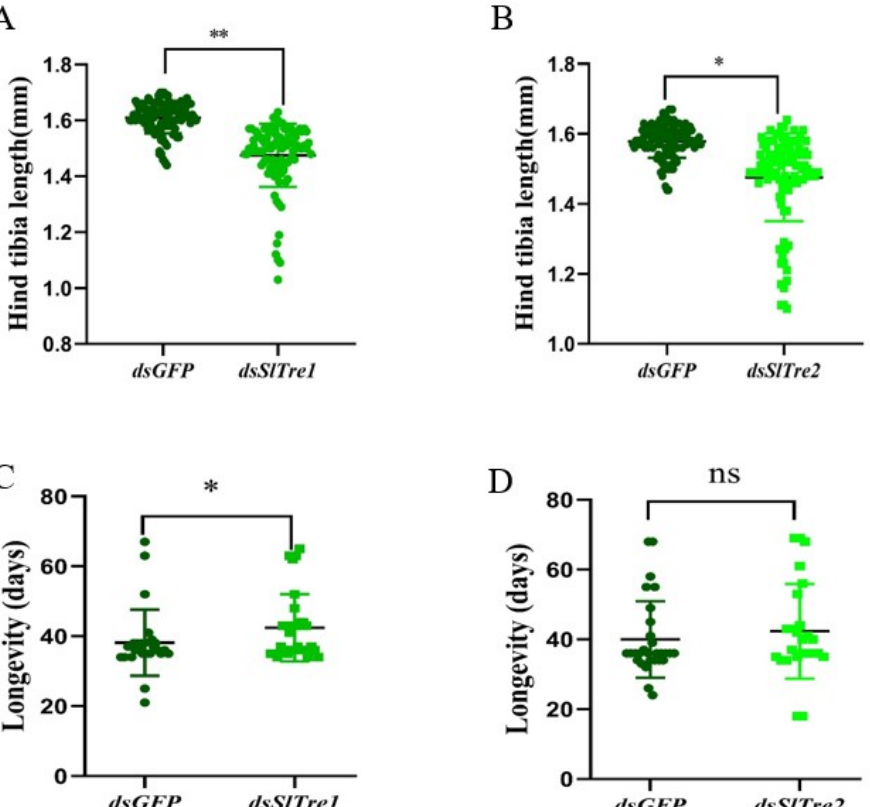
SlTre1 or SlTre2 on emergence rate ( A , B ), the proportion of abnormal adults ( C , D ), and morphology of abnormal adults of parasitic wasp offspring egressed ( E – G ) from parasitized S. litura larvae. Significant differences were compared using ANOVA. Significant differences are indicated by asterisks (* p < 0.05; ns: no significant differences); Scale bars in ( E – G ): 2 mm.